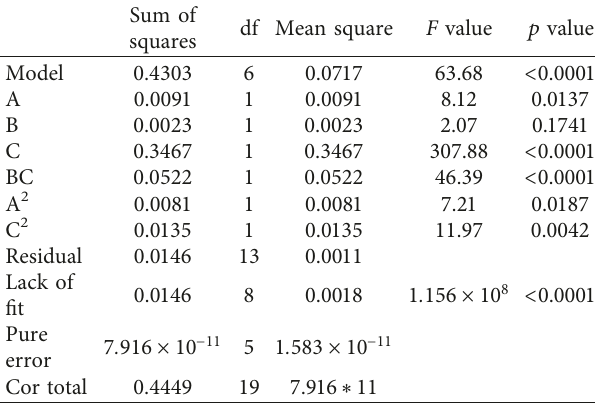
Table 4: ANOVA of response surface quadratic model for SP. Sum of